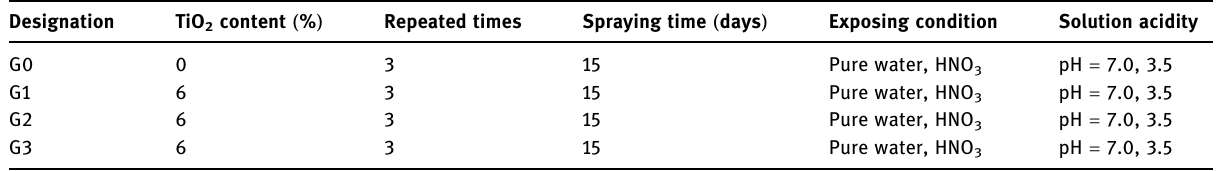
Table 3: Testing details of acid rain